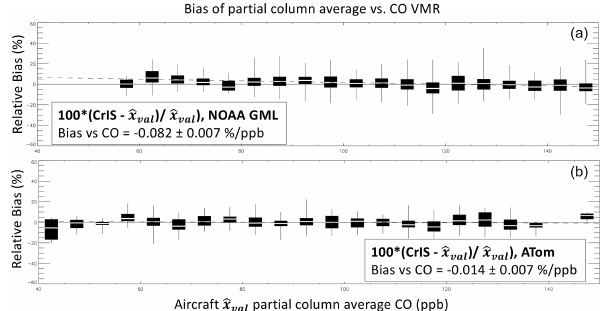
Figure 10. Bias of CrIS partial column average CO vs. CO amount for NOAA GML flights in the top panel and ATom flights in the bottom panel with box–whisker symbols in 5ppb bins. Linear re- gression results are shown in the legend